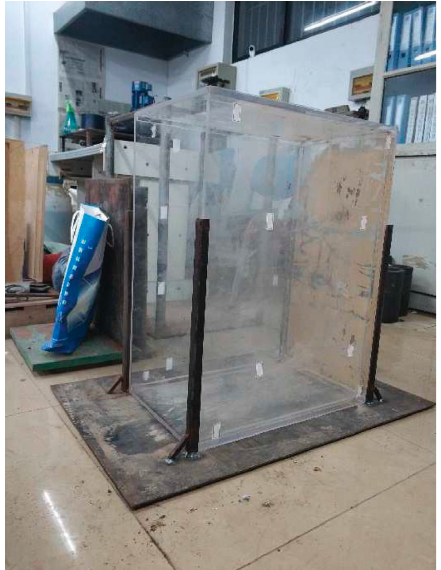
Figure 1: Test model